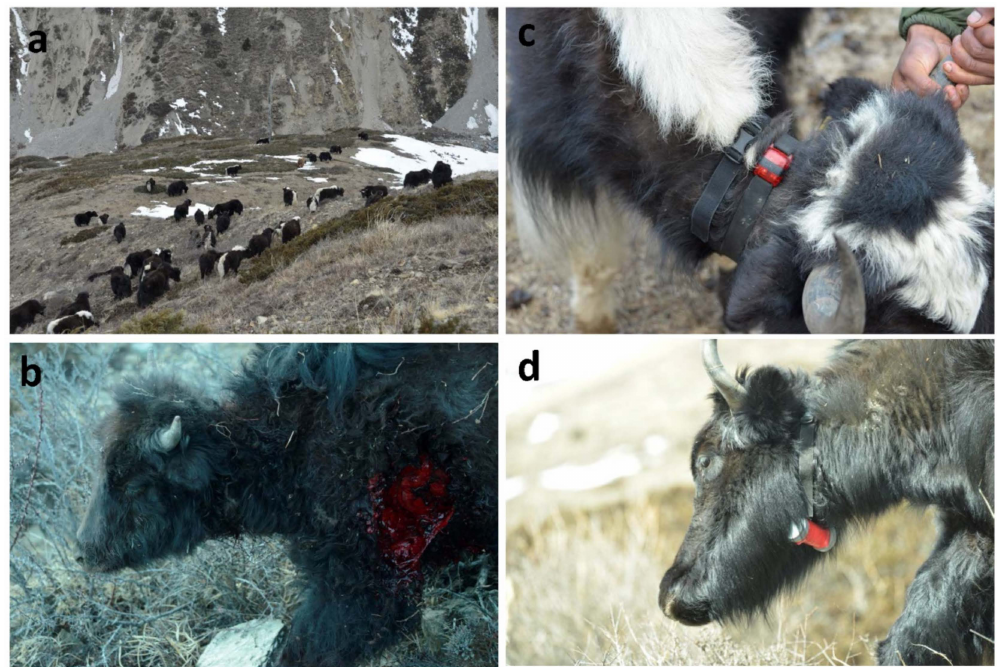
Figure 1. Domestic yaks. ( a ) Herd of yaks. ( b ) Juvenile yak injured by a snow leopard. ( c , d ) Yaks tagged with an Actigraph and a GPS to measure activity, proximity, and